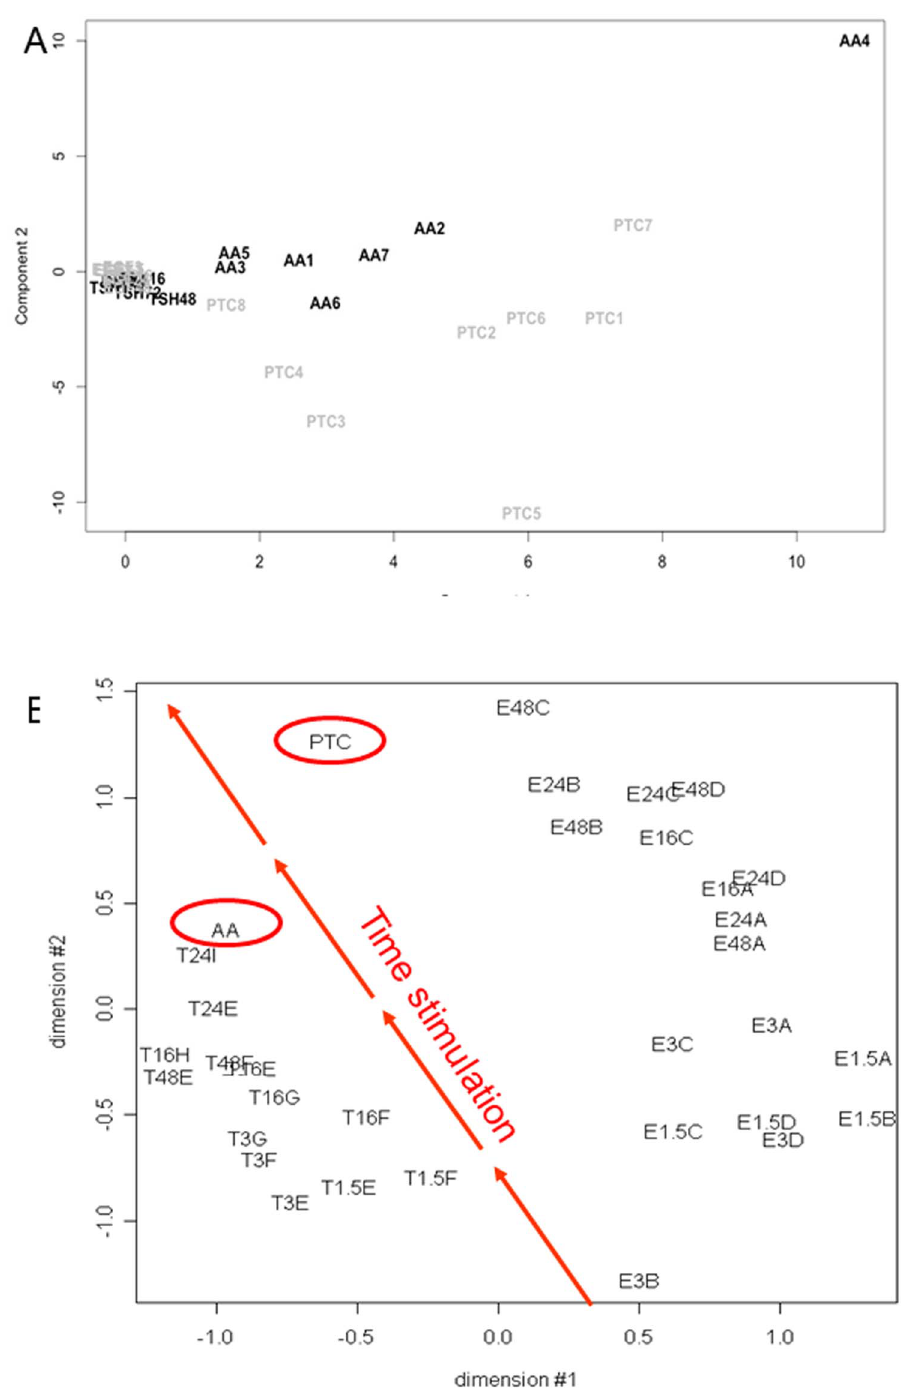
Figure 1. A: Principal Component Analysis of the miRNA expression data from primary cultures stimulated for 1,5, 3, 16, 24 and 48 hours with TSH or with EGF/serum and from tumor tissues (autonomous adenomas (AA) and papillary thyroid carcinomas (PTC)). The two main components are shown. All the treated primary cultured samples are localized close to each other near the origins of the axis, illustrating the low change on the miRNA expression resulting from the treatment. The proportion of variance explained by the Principal Component 1 and 2 are 0.353 and 0.270, respectively. The PCA was generated with R 2.8.1 with the function Prcomp. B: Multi-dimensional scaling analysis (MDS) based on four independent human primary thyroid cell cultures stimulated with 25 ng/ml EGF and 10% serum (E) for 1.5, 3, 16, 24 and 48 hours and on five independent human primary thyroid cultures stimulated with 0.3 mU/ml TSH (T) for similar times [32]. Expression profiles from a pool of autonomous adenomas (AA) and of a group of papillary thyroid carcinomas (PTC) were included. The MDS is based on all the spots present on the array. The distortion of distances (stress) between the MDS 2D space and the actual gene space is 19.6%.